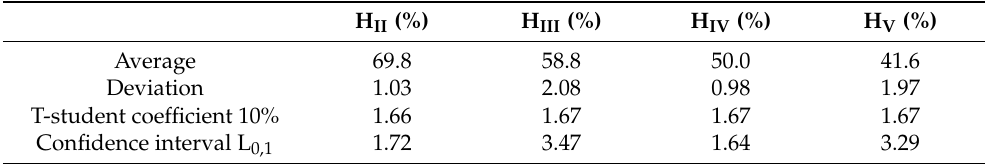
Table 5. Pulse heights on the flaw detector screen—determination of measurement errors in the defect area (the complete set of results are available in the Appendix A, Table A1).